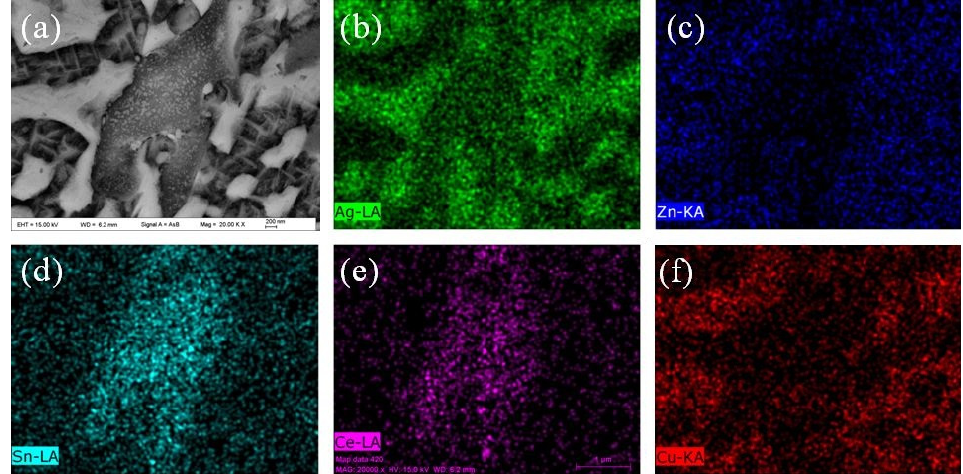
Figure 8. EDX result of the RE-phase in the Ag16.5CuZnSn-0.15Ce brazed joint after aging treatment for 600 h: ( a ) microstructure of the RE-phase, ( b ) Ag, ( c ) Zn, ( d ) Sn, ( e ) Ce, ( f ) Cu.